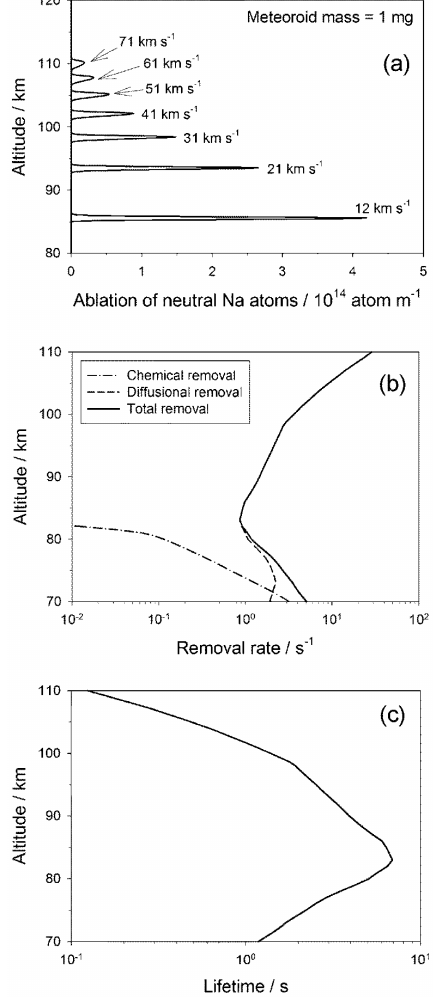
Figure 5. Modelling results: (a) the ablated mass for a 1mg mete- oroid with different entry velocity; (b) variation of the removal rate with altitude due to diffusion and chemistry; (c) the dependence of meteor trail lifetime with altitude.